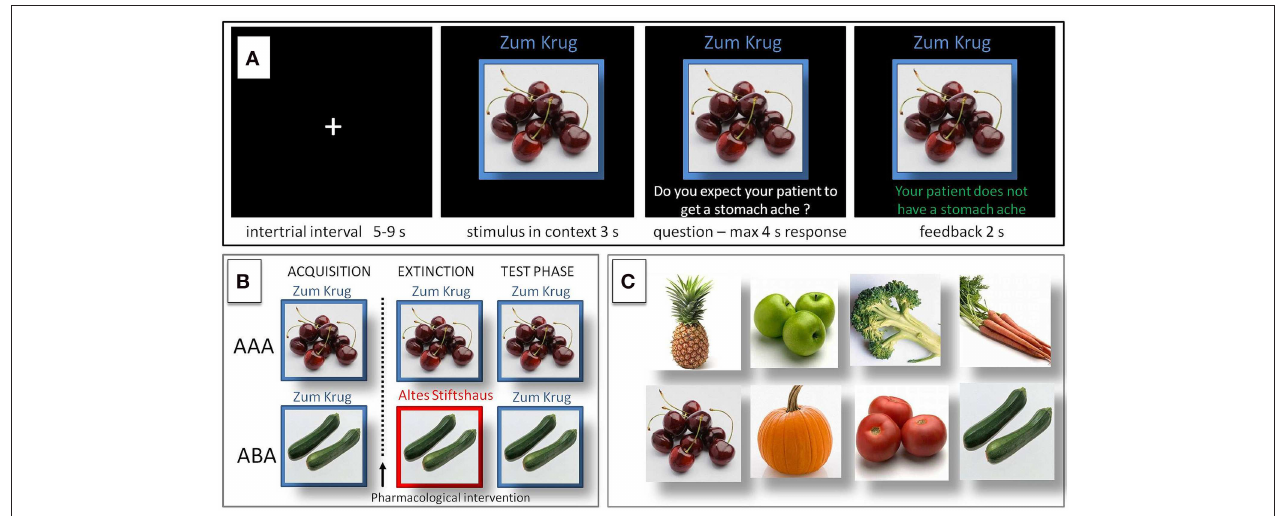
FIGURE 1 | Predictive learning task. (A) Example of a trial during acquisition of the task. Participants learned to predict whether certain kinds of food, eaten in a certain restaurant, would cause a stomach ache or not. After an intertrial interval of 5–9s the stimulus was presented in its context for 3s, then a question was superimposed on the screen “Do you expect your patient to get a stomach ache?” for maximum 4s response time. Feedback was shown for 2s, providing the correct answer, e.g., “The patient does not have a stomach ache.” (B) Design of the predictive learning task. In condition AAA, extinction occurs in the same context as acquisition. In condition ABA, extinction occurs in a context different from that during acquisition. In both conditions, the final test for the renewal effect is performed in the context of acquisition. (C) Food images used as